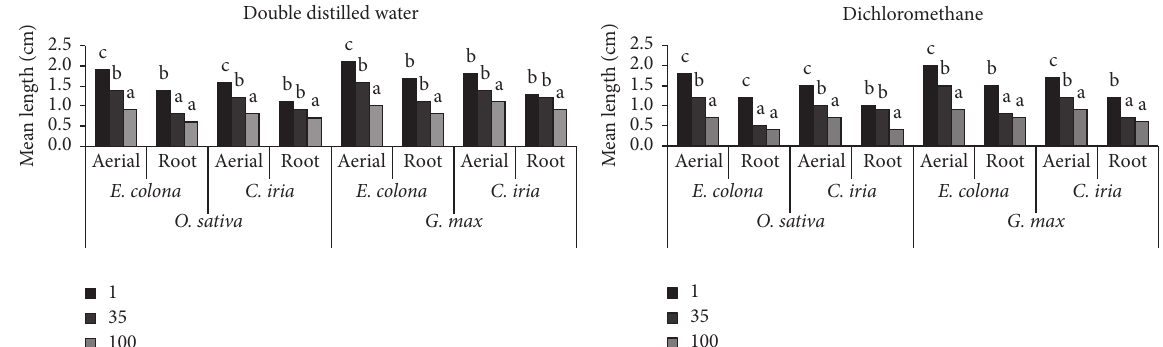
Figure 2: Difference between seedling lengths in double distilled water and DCM extracts with respect to different concentration.